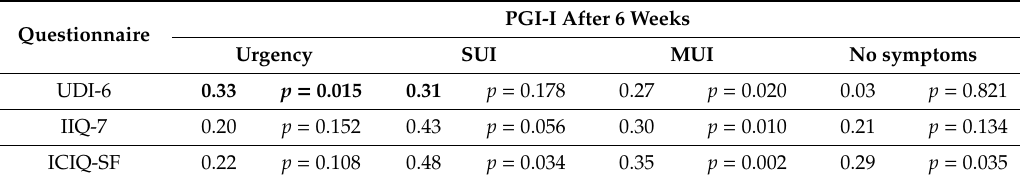
Table 4. The relationship between Patient Global Impression of Improvement (PGI-I) and the severity of functional disorders 6 weeks after